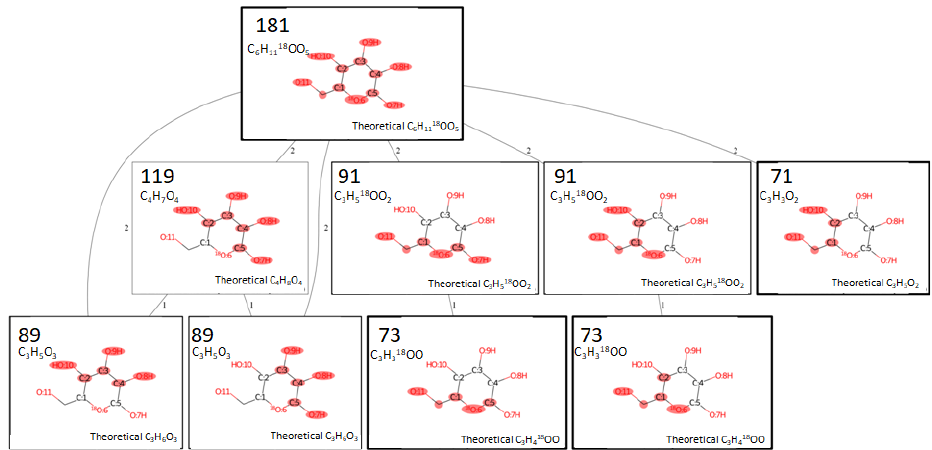
Figure 4. The fragmentation tree obtained for D-glucose after 16 O/ 18 Oexchange reaction. Numbers correspond to the integer m / z value.The highlighted groups are retained in the fragment ion.